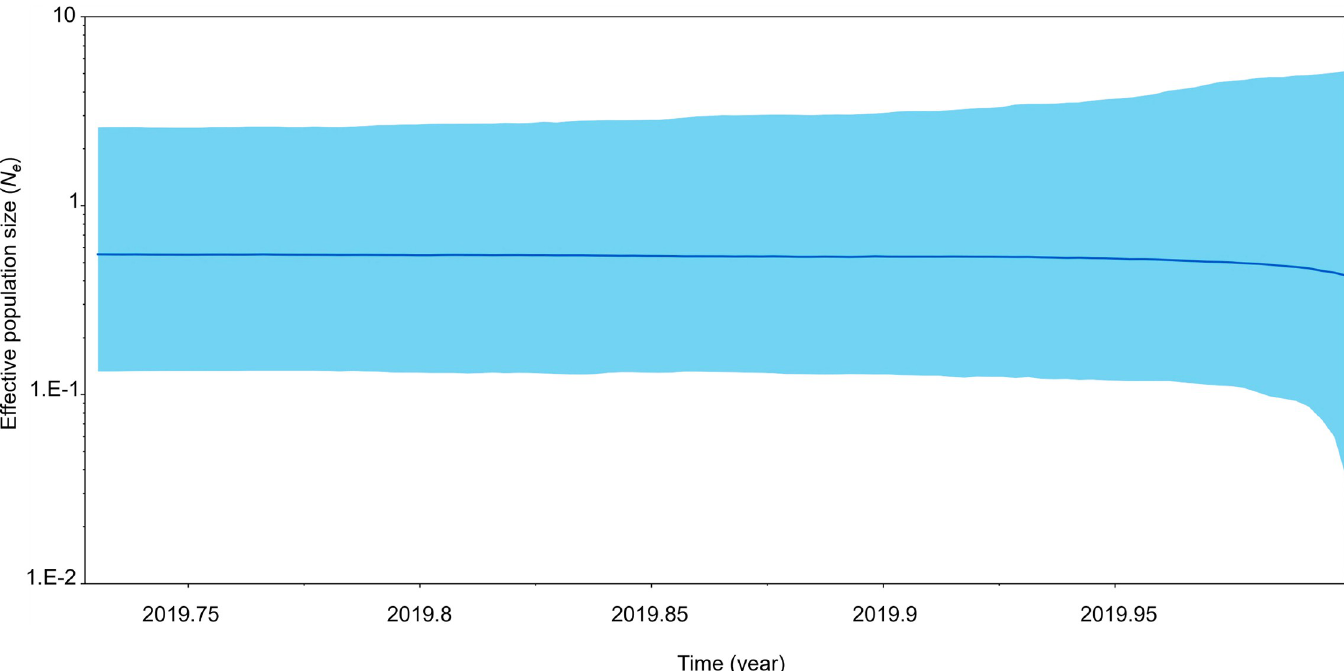
Fig 3. Coalescent Bayesian Skyline analysis output. The black line represents the median estimated effective population size, while blue areas represent the upper and lower bounds of the 95% higher posterior density interval. The x-axis is time and the y-axis is a log scale.